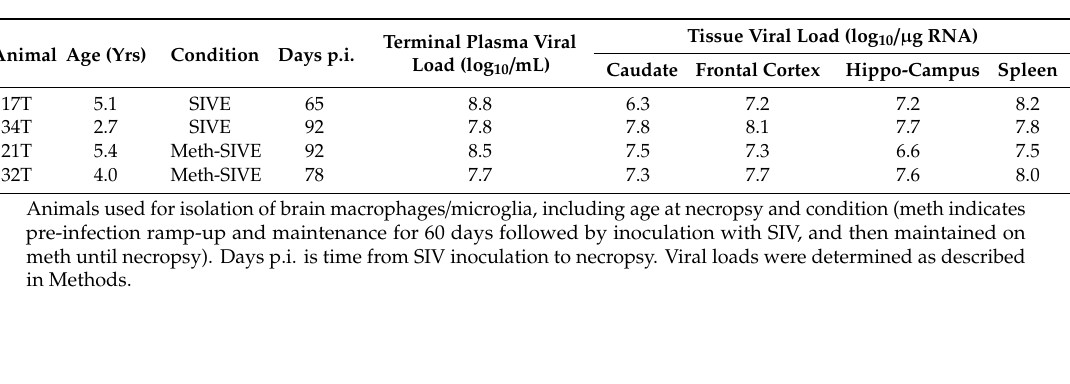
Table 1. Specifics on the animals used in this